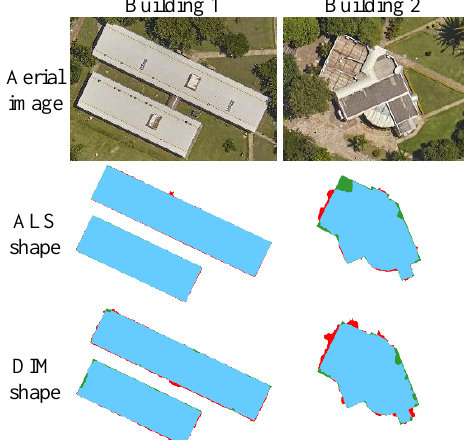
Figure 4. Building roof shape extraction quality assessment. Legend: TP (●), FN (●) and FP (●).